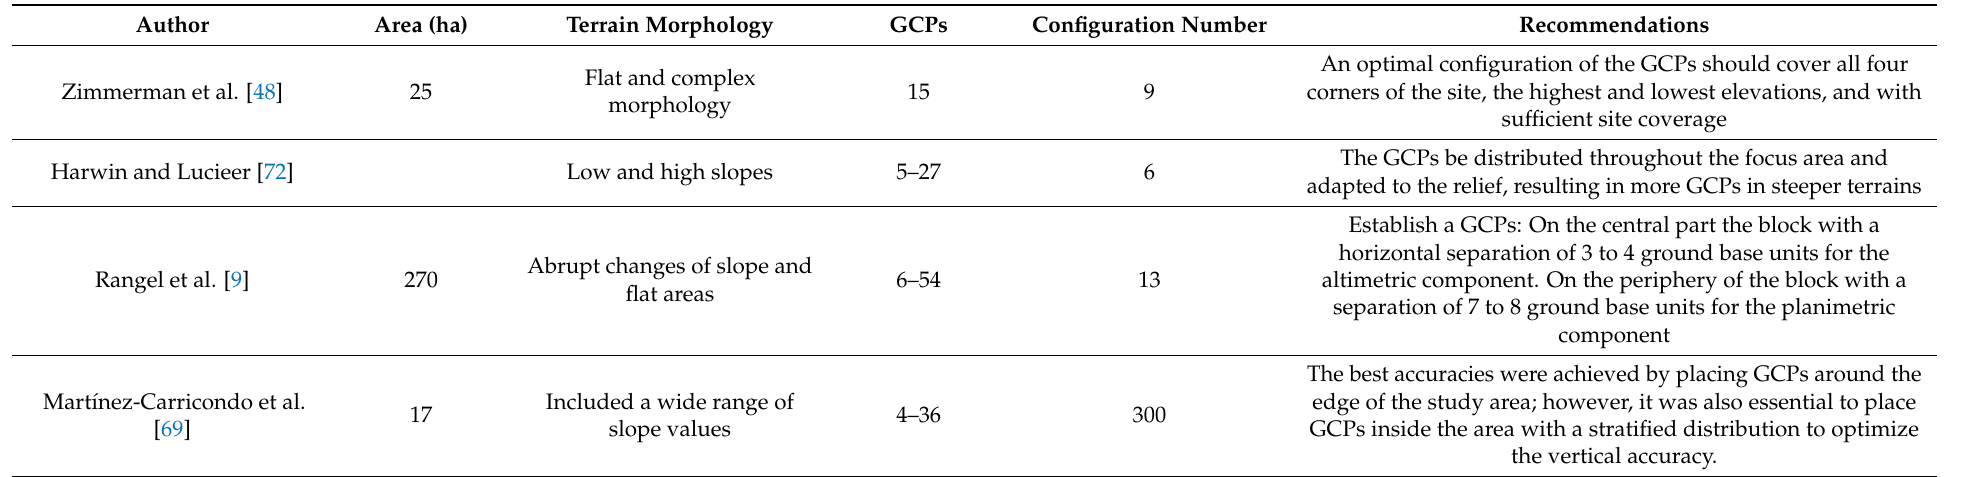
Table 5. Recommendations on the distributions of GCPs as reported in different